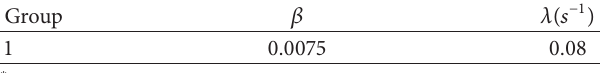
Table 2: Delayed neutron parameters in TWIGL problem ∗ .